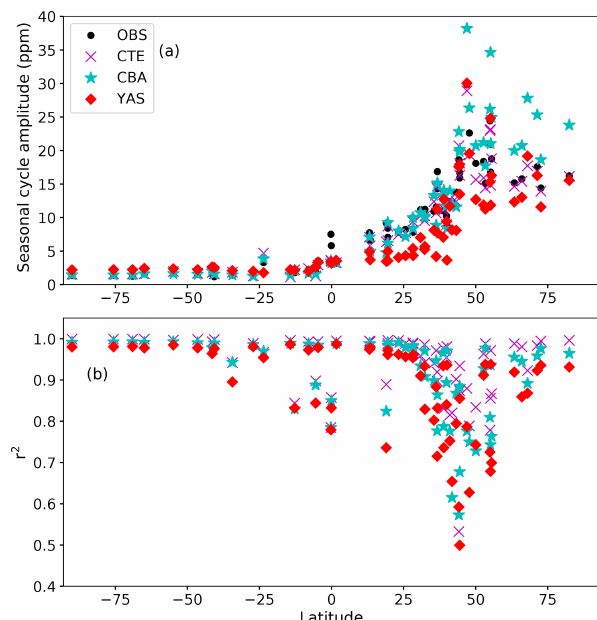
Figure 6. The seasonal cycle amplitudes of atmospheric CO 2 (in ppm) (a) and r 2 (b) between the simulations and observations at dif- ferent Global Atmosphere Watch stations as a function of latitude. The black circles denote observations, the magenta crosses are the results from the CarbonTracker Europe 2016 (CTE), the cyan stars are the results from the CBALANCE (CBA) run, and the red dia- monds are the results from the Yasso (YAS)